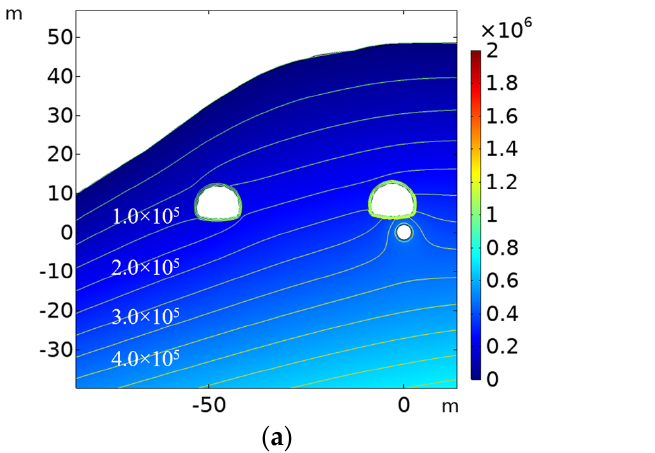
Figure 15. Tunnel and surrounding rock water pressure distribution at 50 m of tunnel exit (unit: Pa): ( a ) before treatment; ( b ) after treatment.